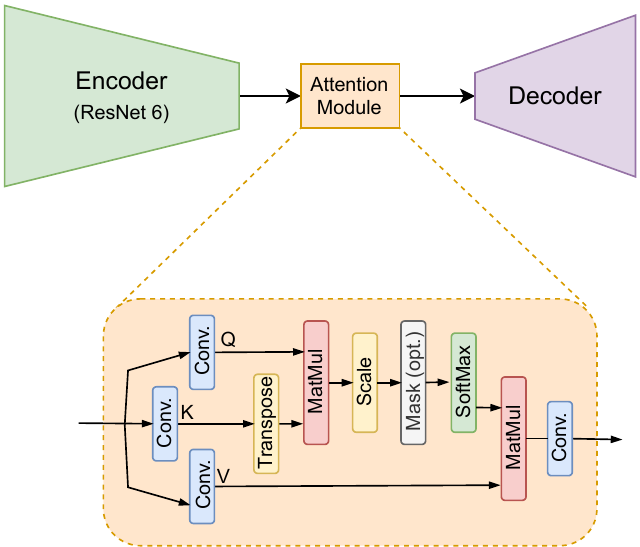
Figure 2. Generator defined by 6 blocks ResNet as encoder, followed by the scaled dot-product attention module [44] and then the